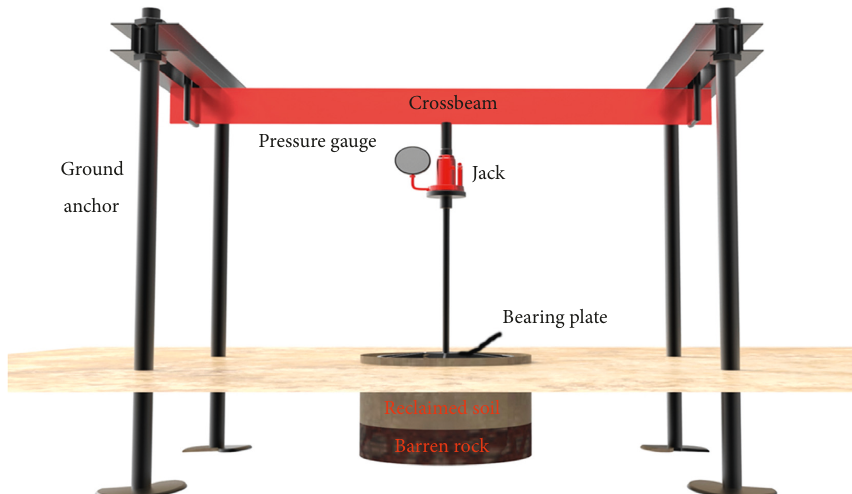
Figure 3: Illustration of the setups in the plate load test.